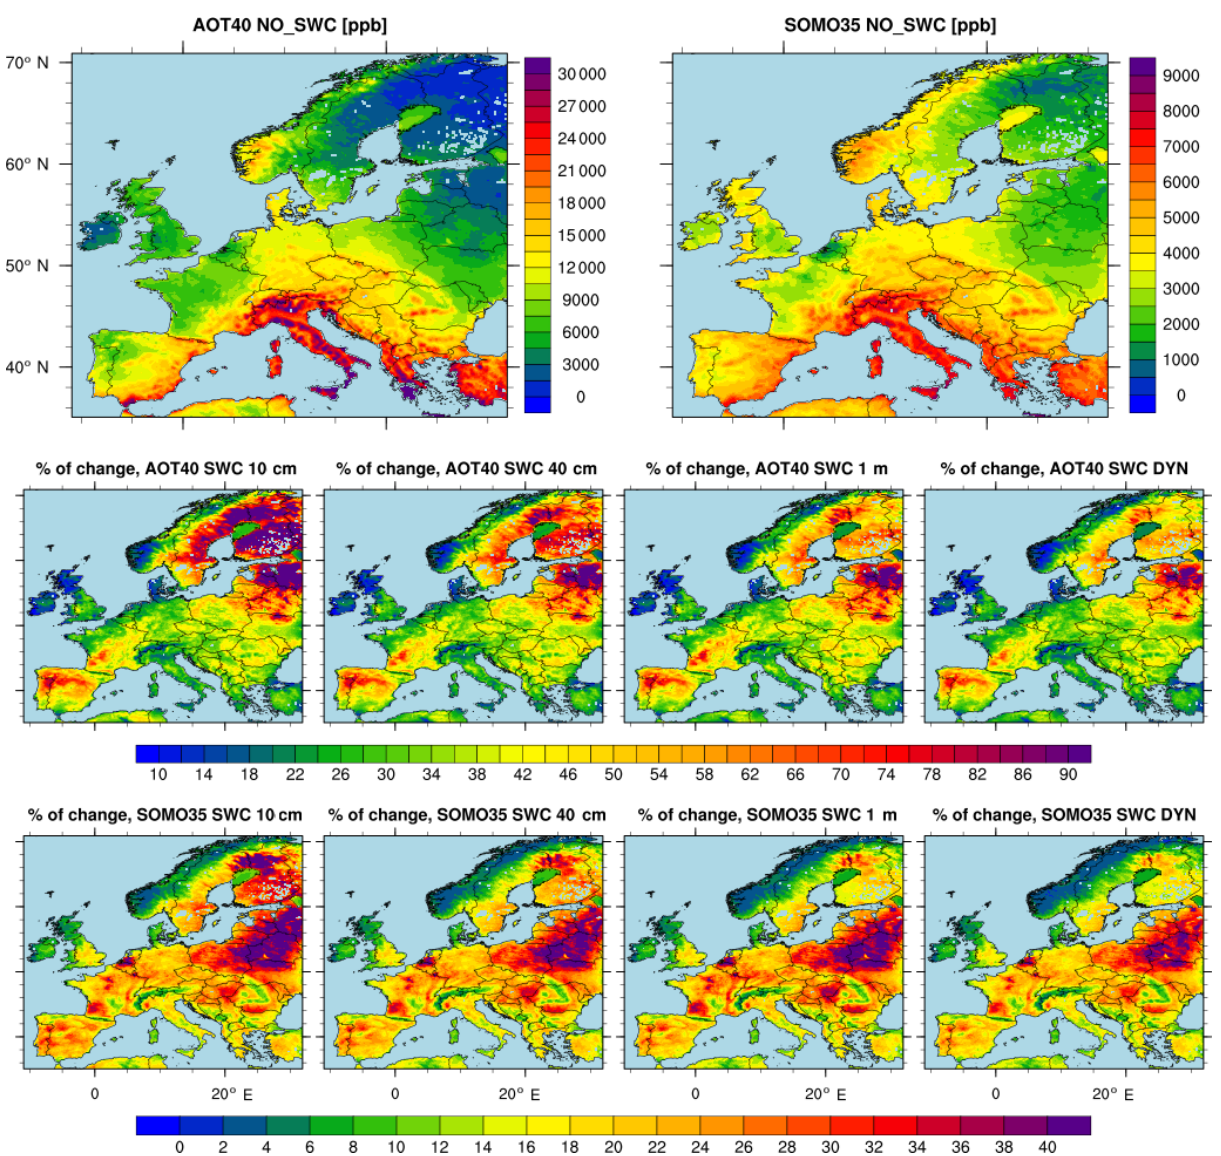
Figure 7. Spatial distribution of AOT40 and SOMO35 (upper panels) along with their percentage change (lower panels) computed using the NO_SWC simulation as reference. The AOT40 is defined as the accumulated amount of ozone over the threshold value of 40ppb computed during the vegetation growing season, i.e. AOT40 = daily maximum of 8h running average ( A d